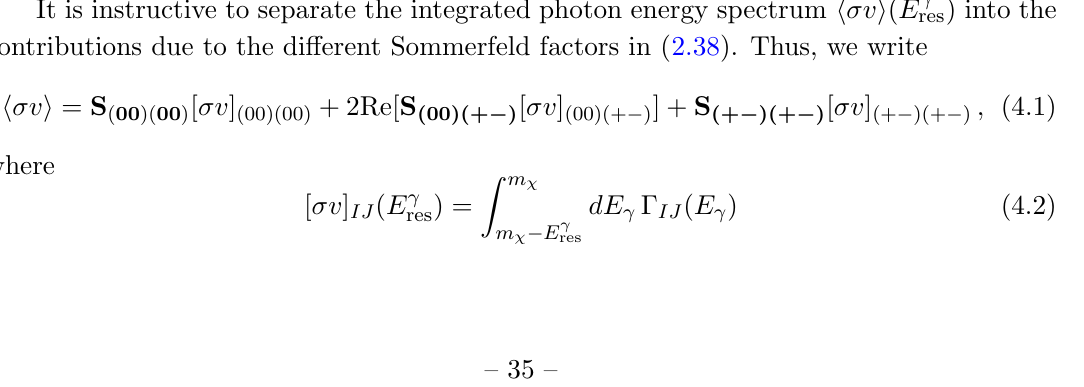
Figure 3 . Integrated photon energy spectrum within E γ (Sommerfeld only) and LL, NLL, NLL’ resummed approximation. The energy resolution is set to = m W . The shaded/hatched bands show the scale variation of the respective approximation E γ res as described in the text. For the NLL’ result the theoretical uncertainty is given by the thickness of the red